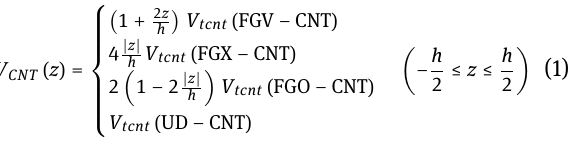
annular sector plates, i.e. UD-CNT, FGX-CNT, FGO-CNT